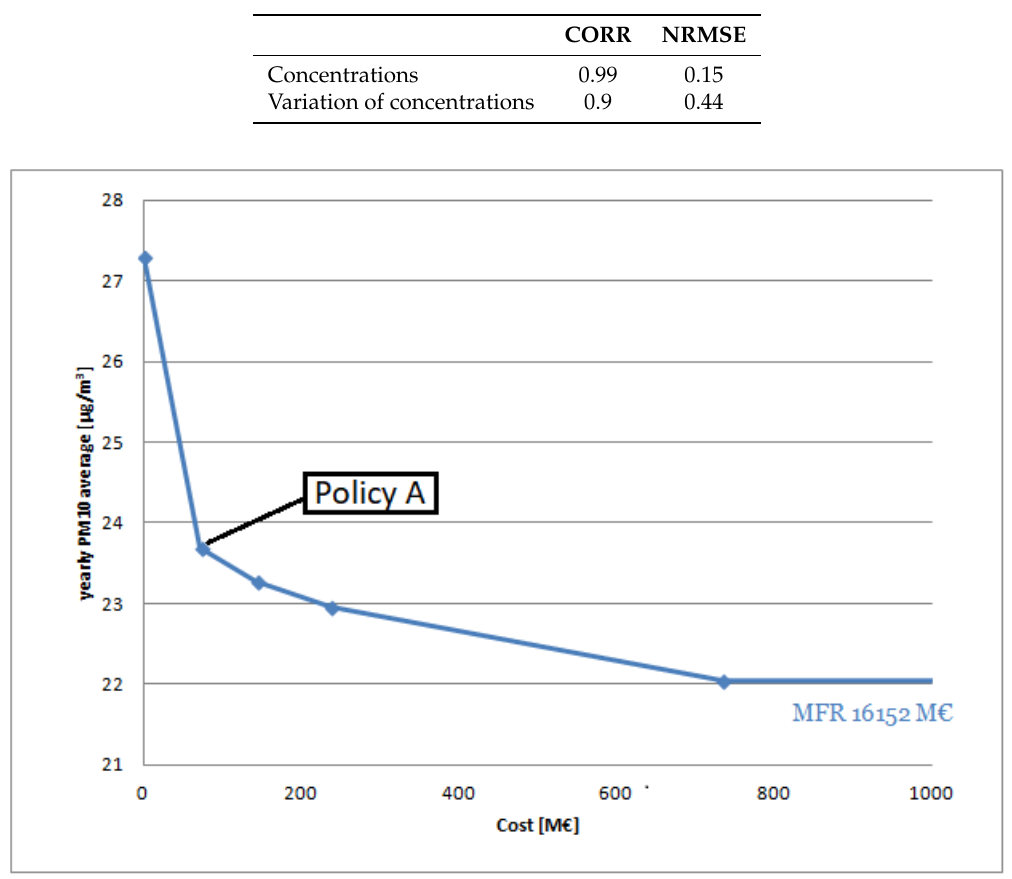
Table 2. Correlation (corr) and normalized root mean squared error (nrmse) resulting from the validation of the ANN model applied in the current work to reproduce PM 10 yearly concentrations.